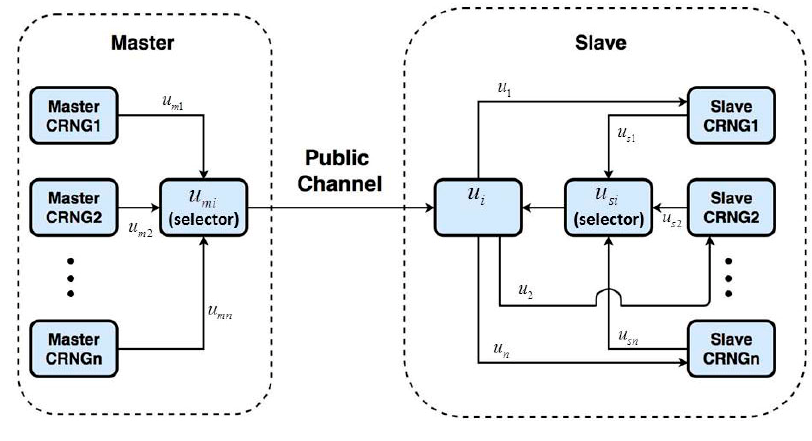
Figure 12. Synchronized large-scale CRNGs.